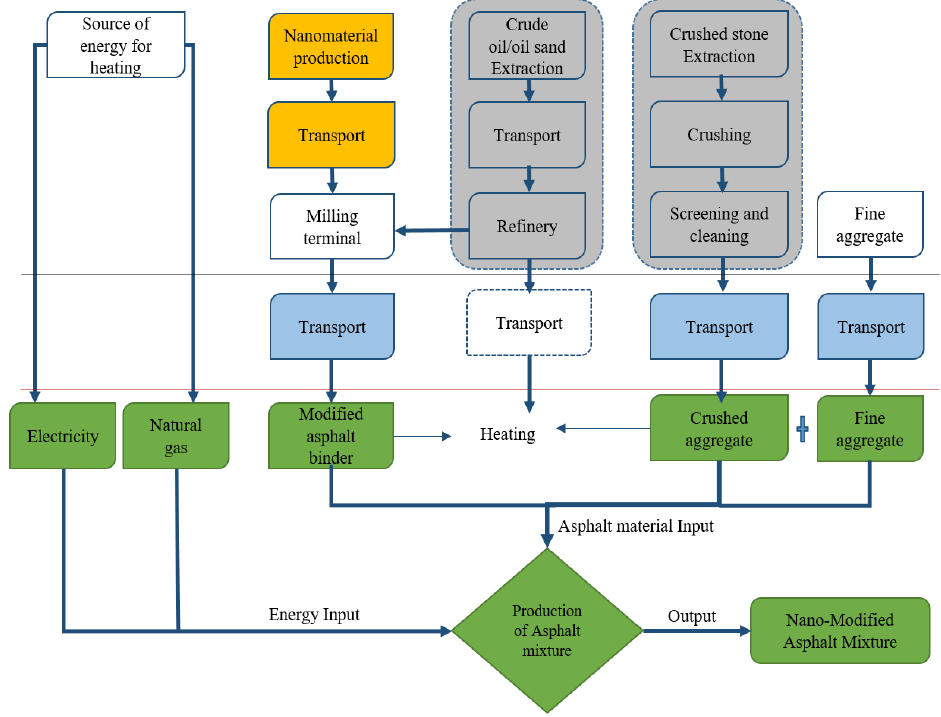
Figure 3. Key processes of nano-modified asphalt materials.